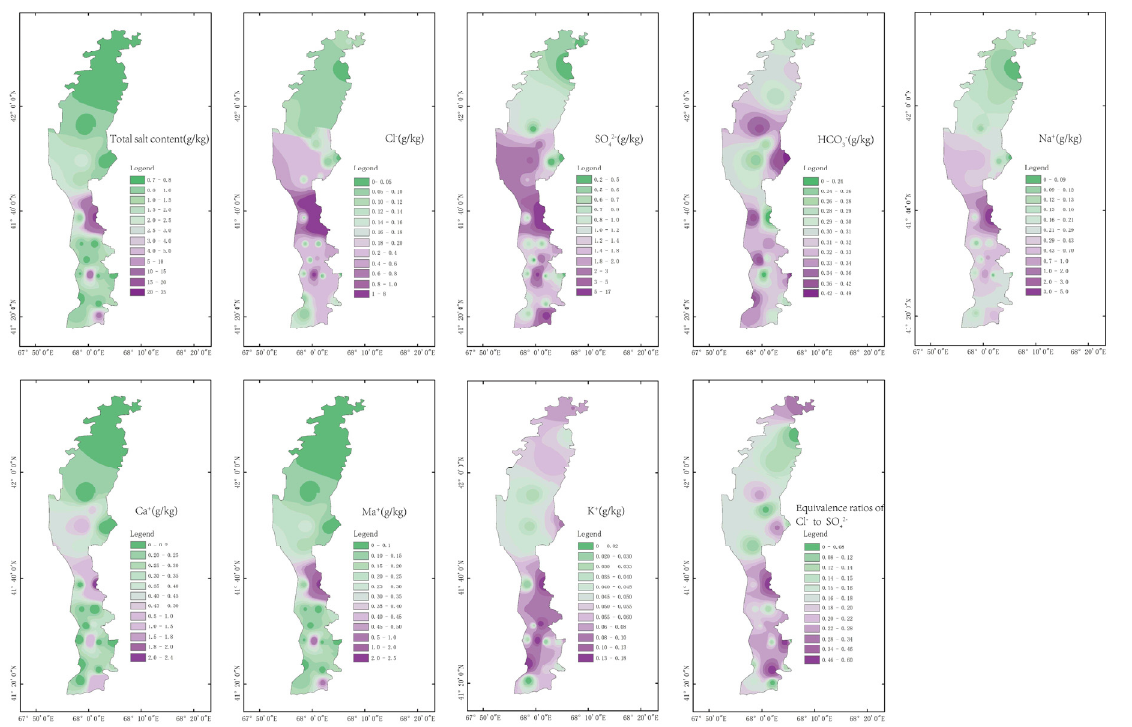
Figure 3. Spatial distribution of salinity, major salt ions, and Cl − /SO 42 − equivalent ratio of cropland in the Shardara